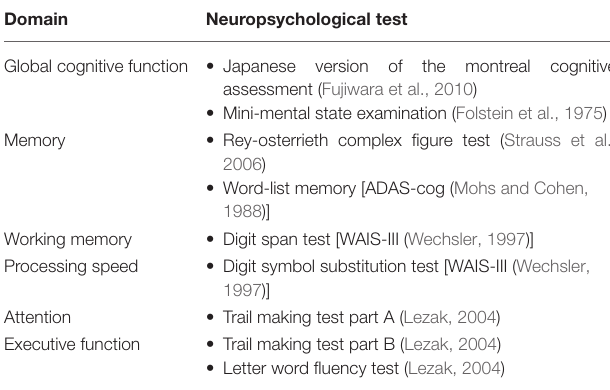
TABLE 2 | Primary outcome measures in the J-MIND-Diabetes trial.